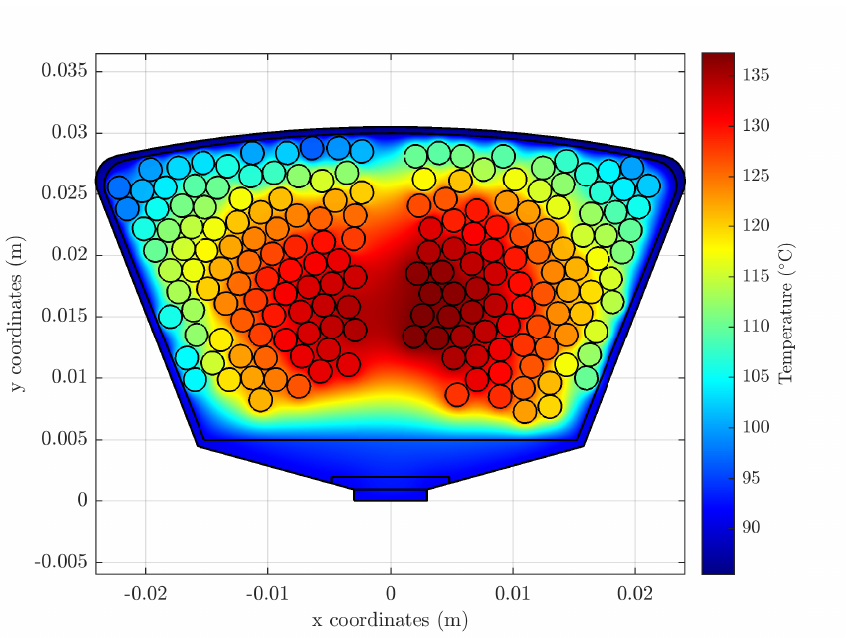
Figure 6. Temperature distribution in the